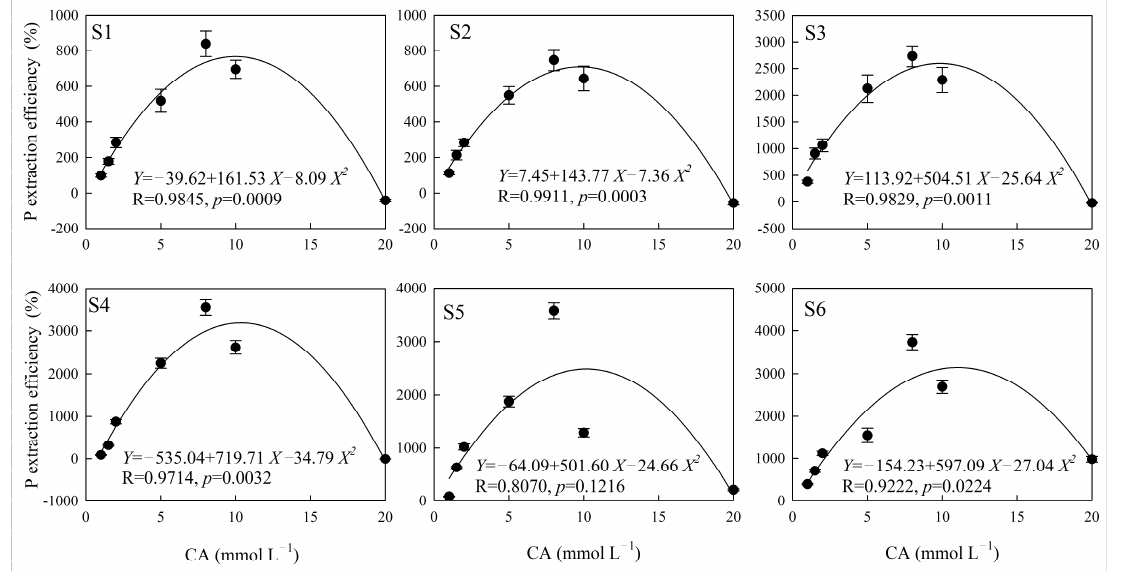
Figure 2. The P extraction efficiency induced by different concentrations of CA. Note: X is the concentration of CA (mmol L − 1 ), Y is the P extraction efficiency of CA (%), R is the correlation coefficient of the fitting equation, and p -value is the significant difference. S1, S2, S3, S4, S5 and S6 are six sampling areas.